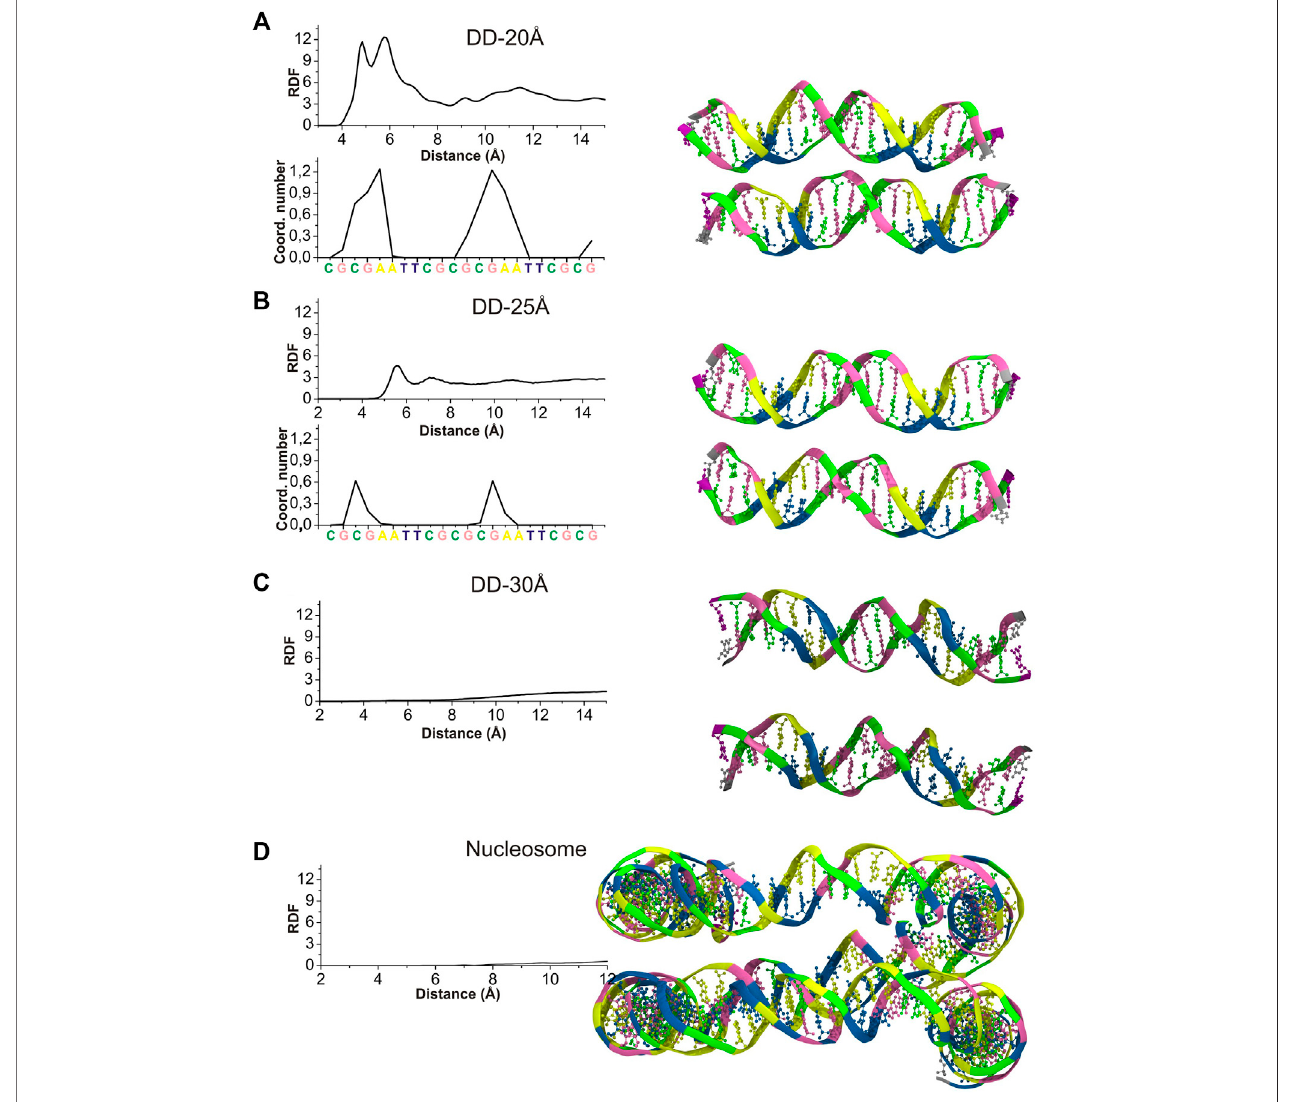
FIGURE 3 | Left: RDF DD s (continuous lines) calculated between the P atoms of phosphate groups belonging to different DNA molecules (or parallel segments for nucleosomeDNA),andthevaluesofintegralsoftheRDFscalculatedforeachindividualphosphategroupupto6.4 Å,revealingthesitesweretheDNA-DNAcontactsare most probable. (A) System DD-20 Å (B) System DD-25 Å. (C) System DD-30 Å (D) Nucleosome DNA system. Right: The snapshots from the MD simulation of each systemarerepresentedattherightsideofthecorrespondingRDF.Coloringscheme:A,yellow;T,blue;C,green;G,pink.Spd 3+ ,waterandionshavebeenomitted for